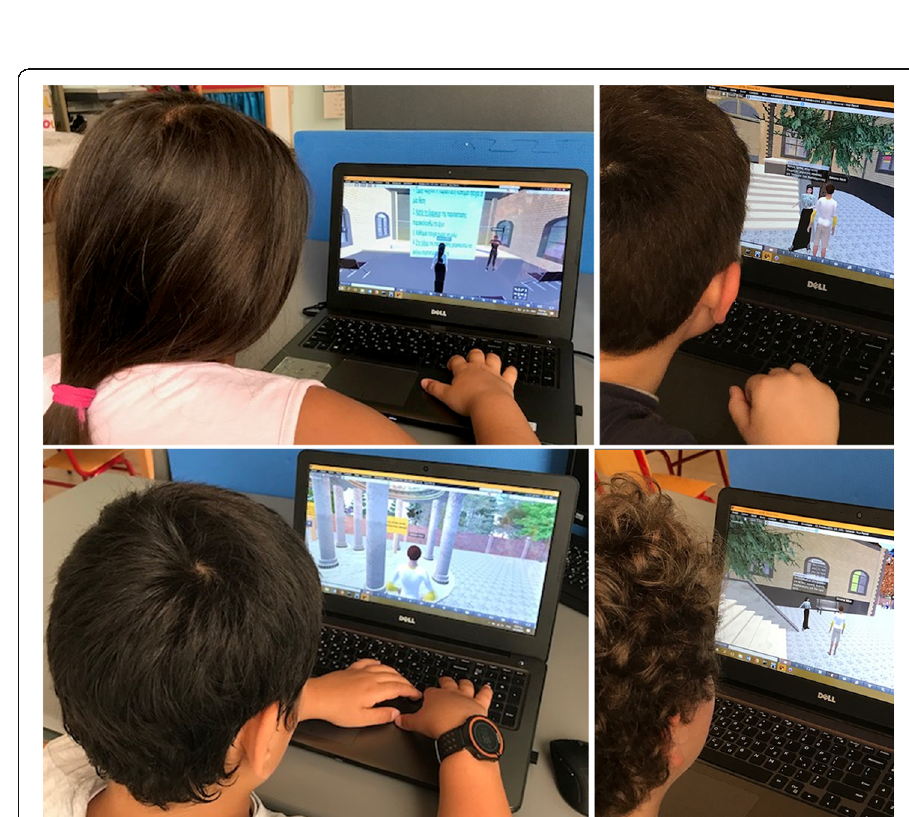
Fig. 2 Screenshots from the